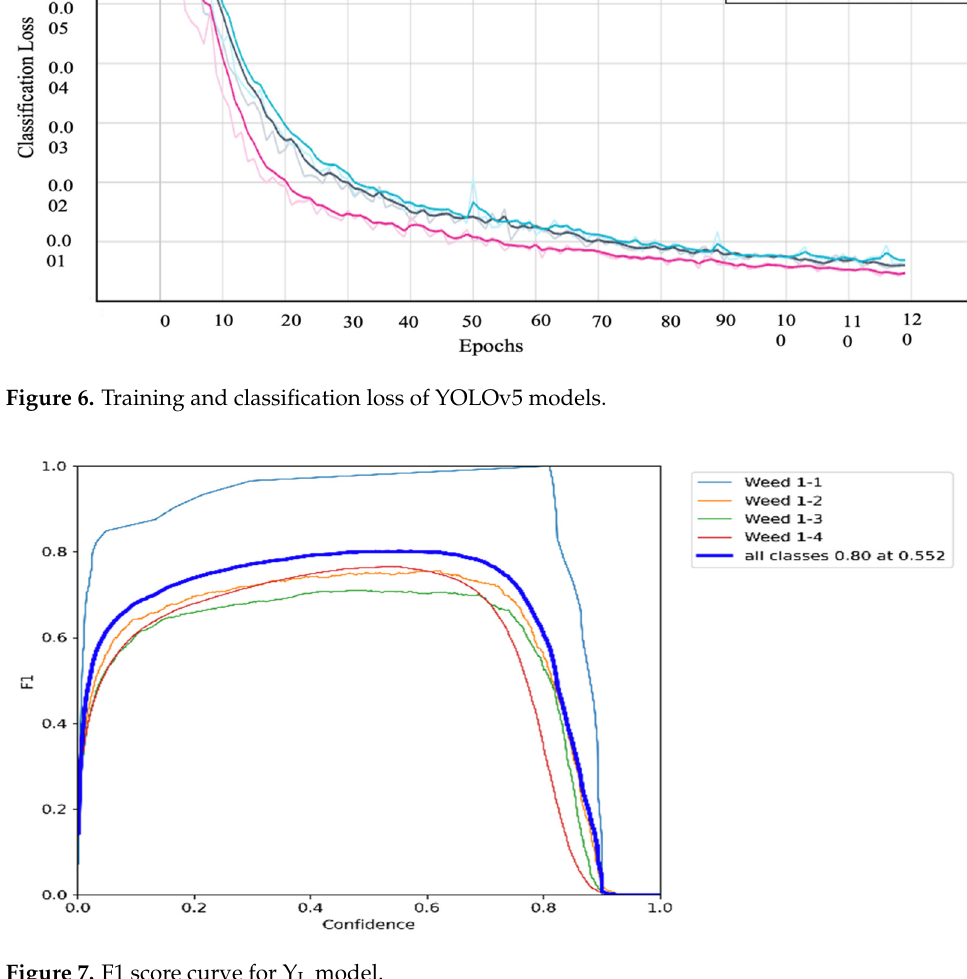
Table 7. Detecting weed growth stages using Faster R-CNN and RetinaNet.